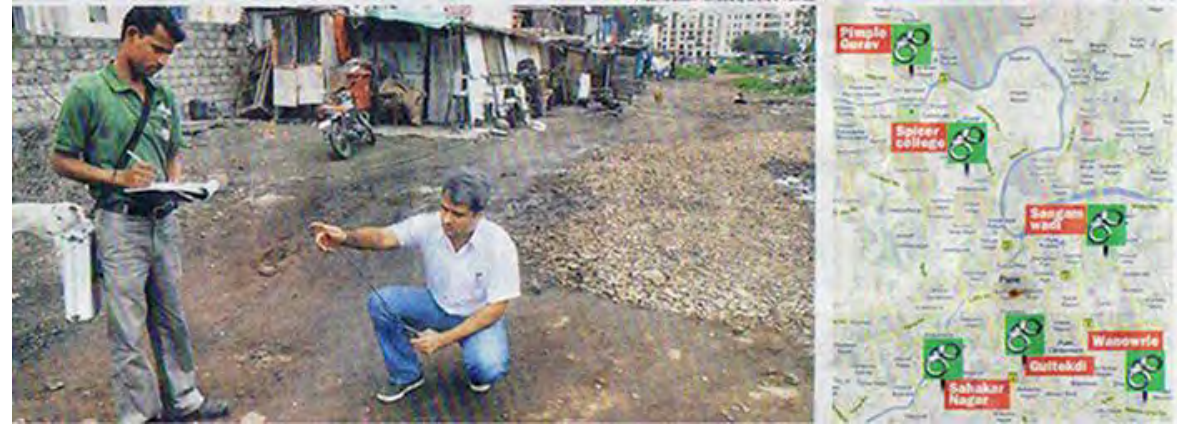
Figures 10: Geostress measurement near Crime area & map of Pune city showing crime